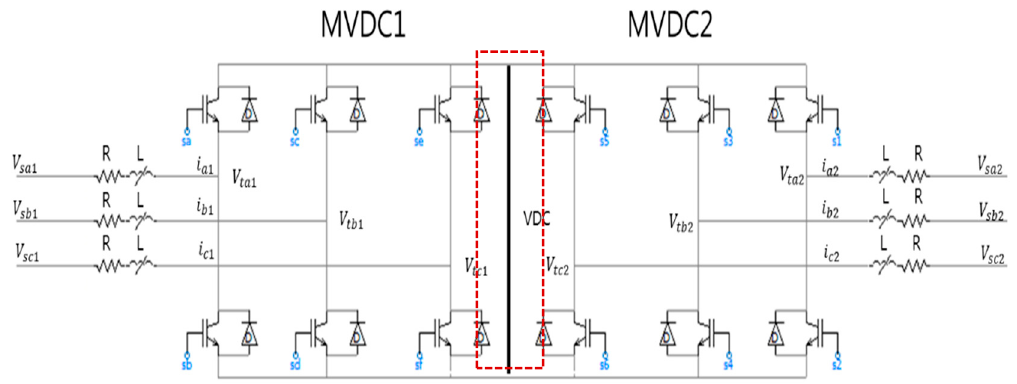
Figure 4. The proposed MVDC connection between Gapado Island and Marado Island.